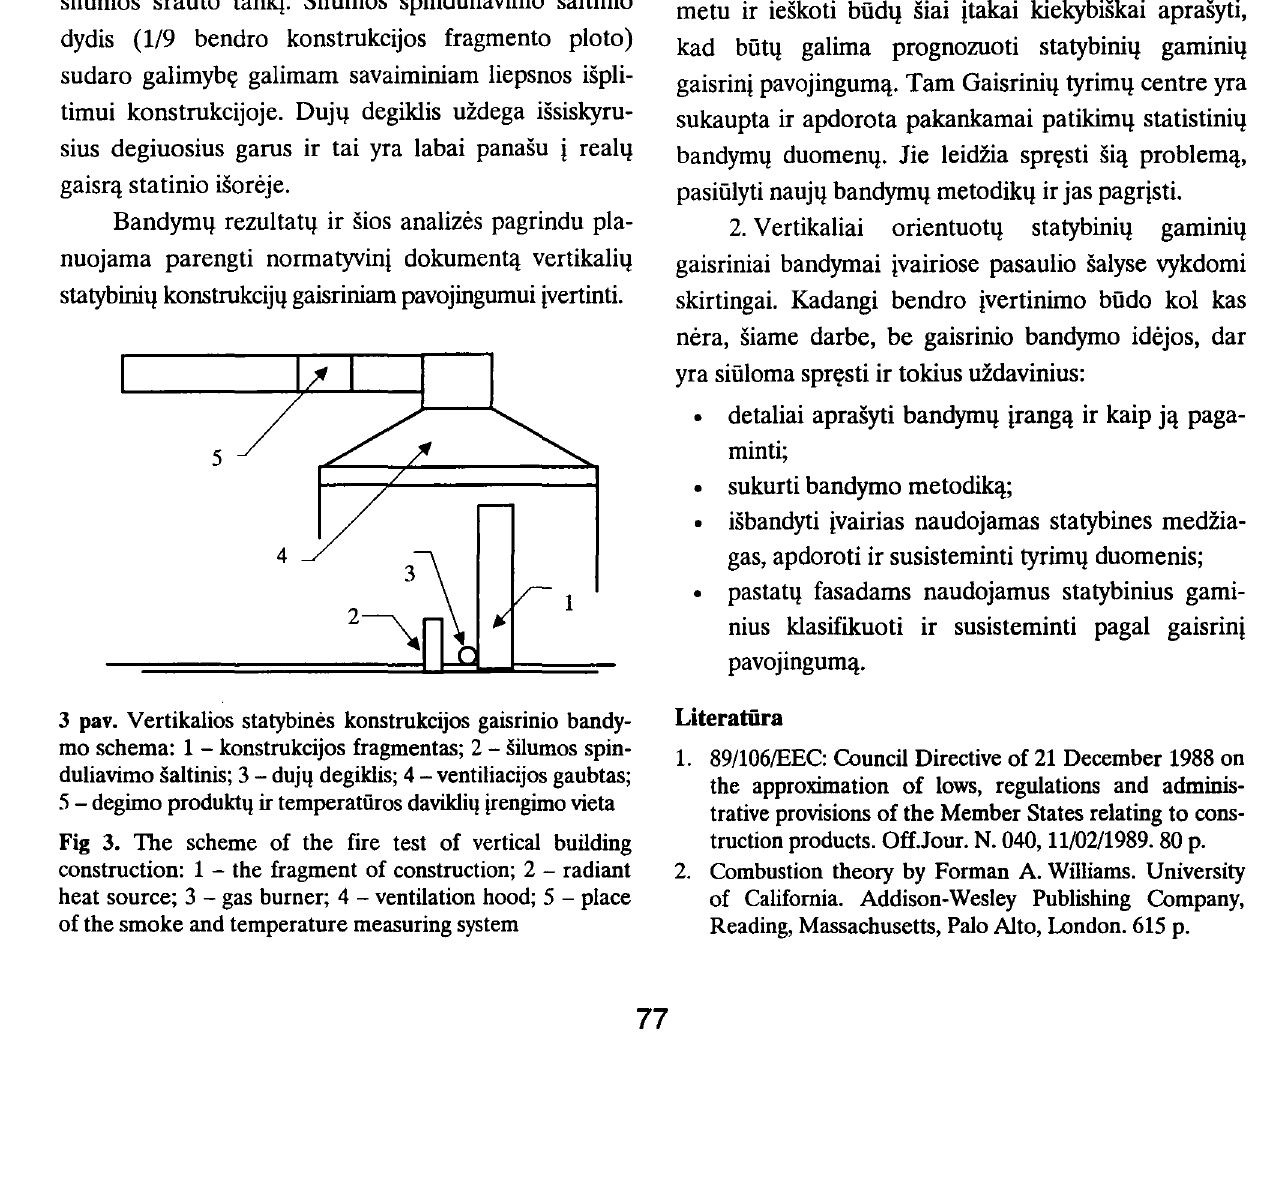
Fig 2. The dependency of the combustibility time ( T) of building product from the